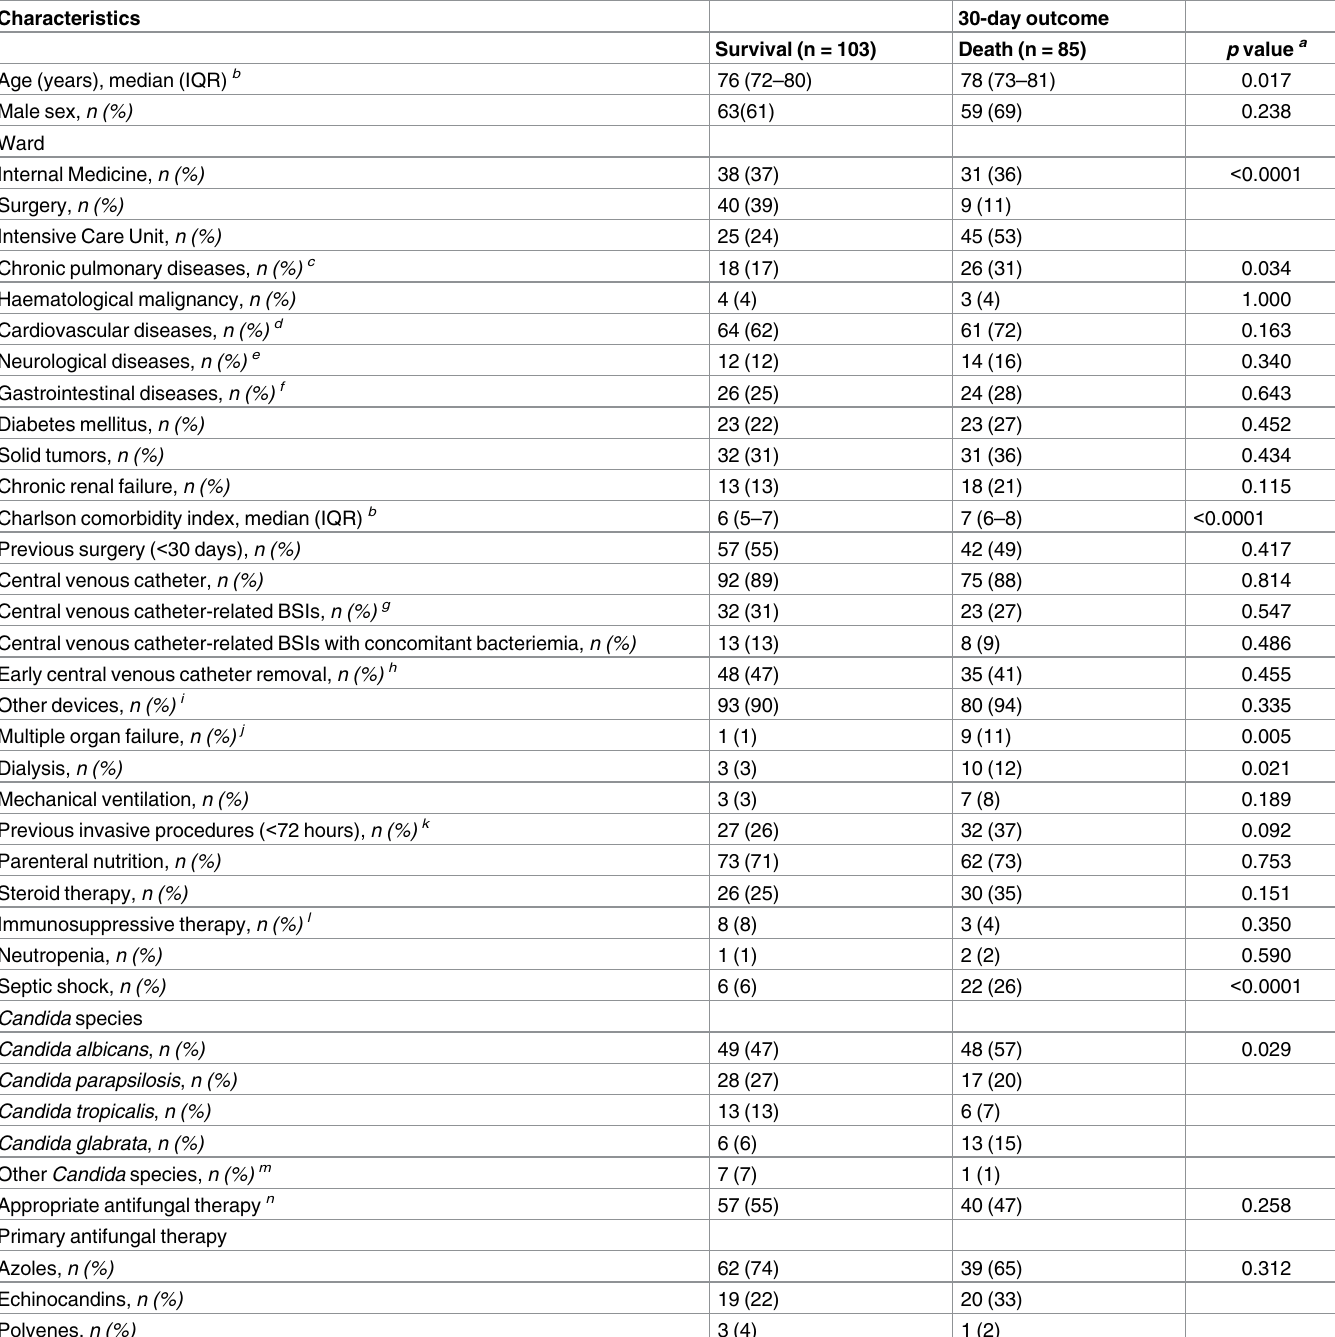
Table 2. Outcome of 188 elderly patients with BSIs due to Candida species considered in this